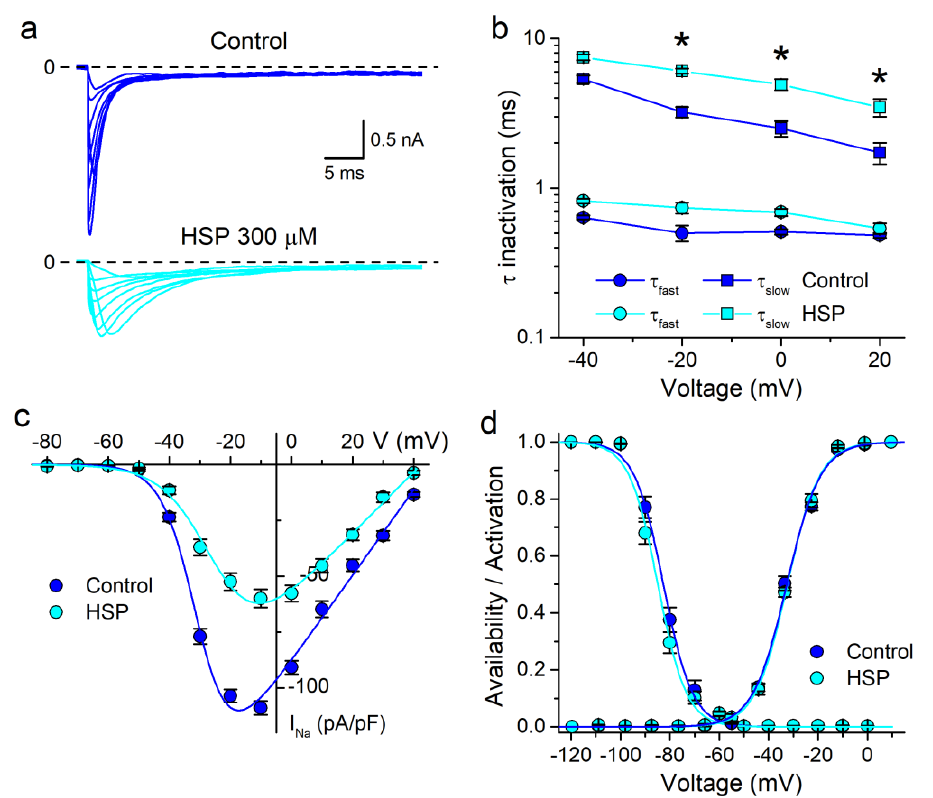
Figure 4. Lack of voltage-dependent effects of hesperetin on I Na in the ∆KPQ mutant channels. ( a ) Examples of ∆KPQ hNa V 1.5 currents elicited by voltage pulses applied from a holding potential of −100 mV to between −40 and +30 mV in 10 mV steps, in the control and in the presence of HSP 300 µM. ( b ) Voltage-dependency of τ fast and τ slow in control and in the presence of HSP (300 µM). The action of HSP on τ fast was not voltage-dependent. The increase in τ slow by HSP was more marked at potentials between −20 and 20 mV (* p < 0.05 with respect to the effect at −40 mV). ( c ) I–V relationships from ∆KPQ hNa V 1.5 expressing HEK293T cells in the control condition and in the presence of HSP 300 µM. The dots represent the mean ± s.e.m. ( n = 19). HSP significantly decreased the current in the voltage range from −40 to +40 mV. ( d ) Availability and activation curves for ∆KPQ hNa V 1.5 channel in the control and in the presence of HSP 300 µM. The dots represent the mean ± s.e.m. ( n = 19). HSP (300 µ M) significantly reduced the density of ∆ KPQ currents in the range of potentials from Table 1. Parameters obtained from the fits of the I–V relationships and availability curves. Condition 75% ( n = 5) and in 50% the G M of ∆ KPQ currents ( n = 19) (Table 1). HSP did not induce